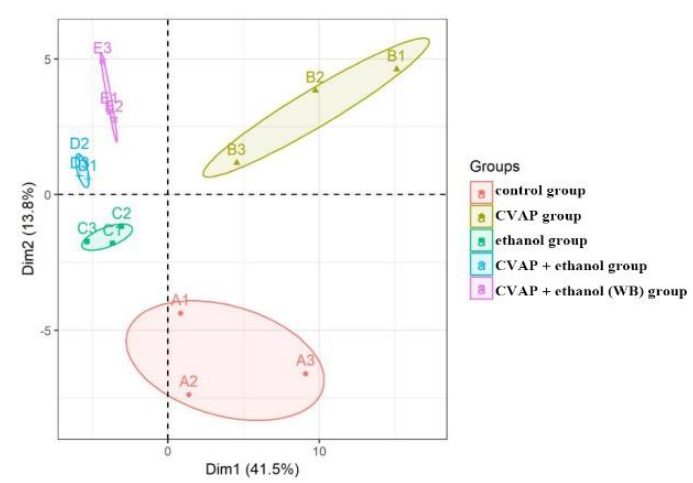
Figure 7. PCA score scatter plot of L-02 cell metabolites.